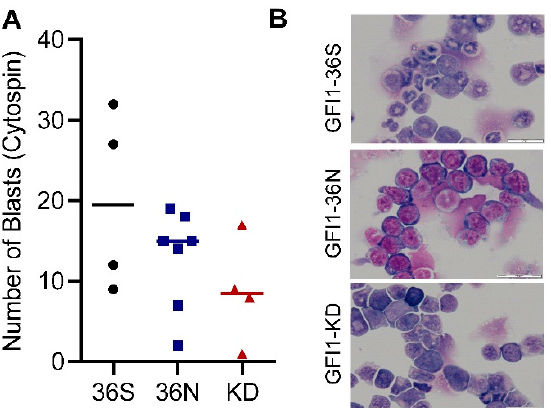
Figure A3. Curcumin treatment reduced leukemic blasts in GFI1-36N and -KD mice. ( A ) Frequency of leukemic blasts (Wright-Giemsa staining) in BM cytospins derived from GFI1-36S/-36N/-KD, NUP98/HOXD13-tg leukaemic mice (n = 4–7 per group). ( B ) Representative images in different groups. Scale bars represent 20 µm respectively.